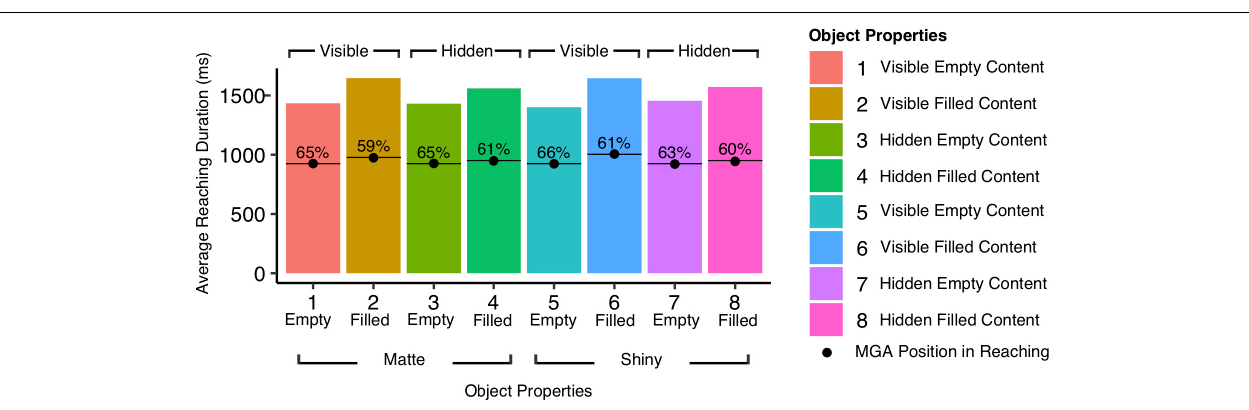
FIGURE 5 | Average duration times in reaching (ms) for the different types of cups presented with respective average timing of the maximum grip aperture (MGA). The figure demonstrates MGA to occur earlier in time when reaching for cups with filled content ( M = 61.67% after movement start) compared to empty and consequently lighter cups ( M = 66.78% after movement start). This effect was present when the timing of MGA was examined in relation to the reaching duration times, but was absent when the timing of MGA was examined as the absolute time from movement